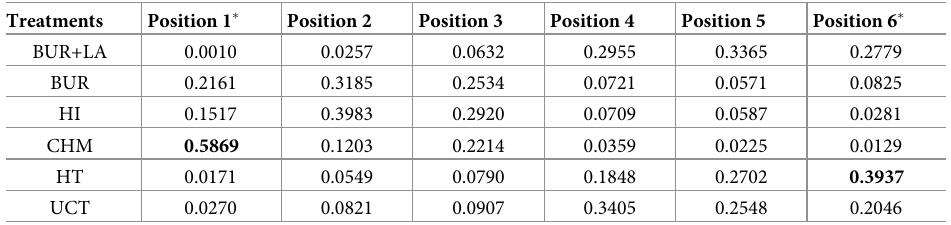
Bold values are the highest values in the selected